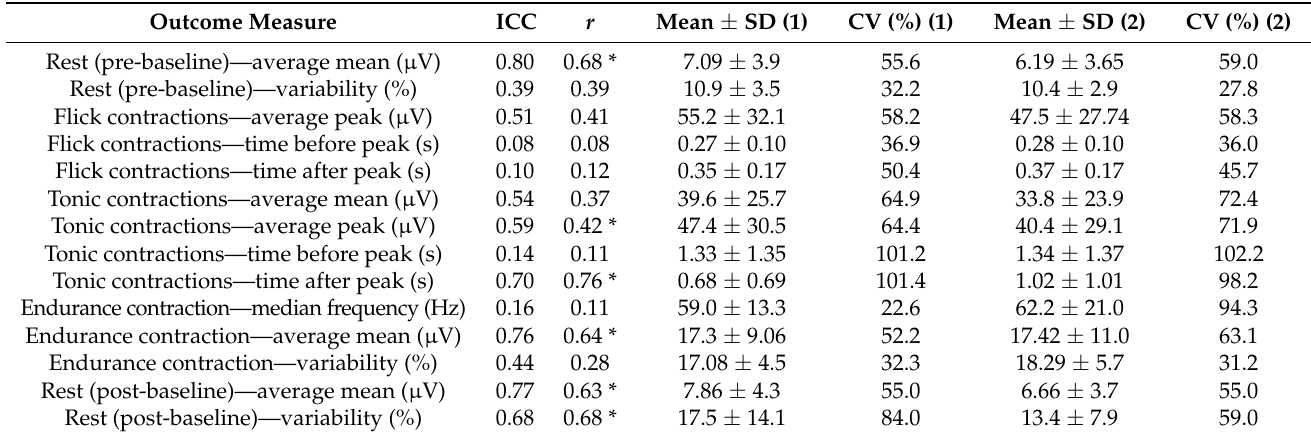
Table 2. The Glazer sEMG protocol between-day reliability.